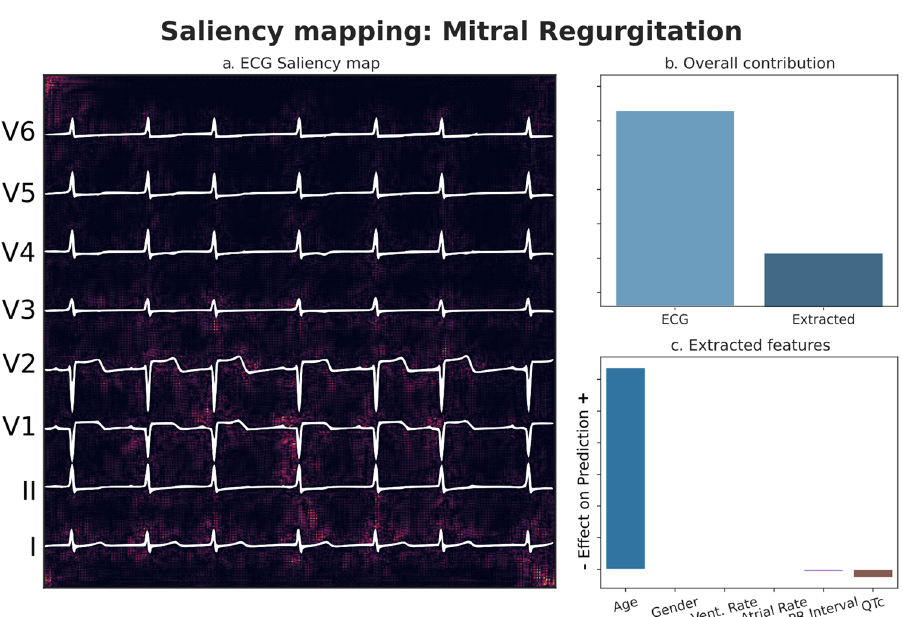
Fig. 4 Model interpretability: Mitral Regurgitation. Panel a Input pixels most responsible for driving the prediction towards the outcome are highlighted. Panel b Relative contributions of waveform / tabular data to the fi nal prediction. Panel c Relative importance of tabular features with respect to each other. Patient (n = 1) was positive for Mitral Regurgitation. Source data for fi gure is available in Supplementary Data